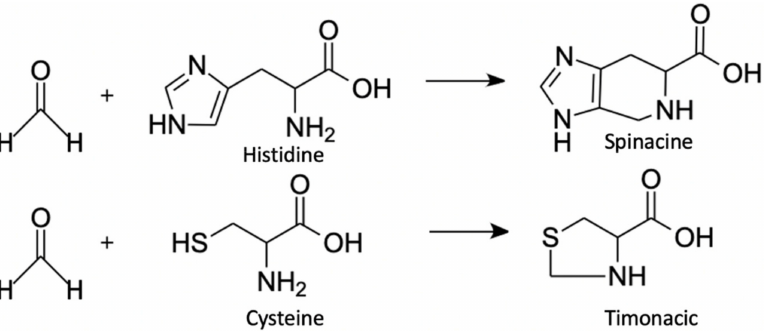
Figure 6. FA reaction with histidine and cysteine to form spinacine and timonacic